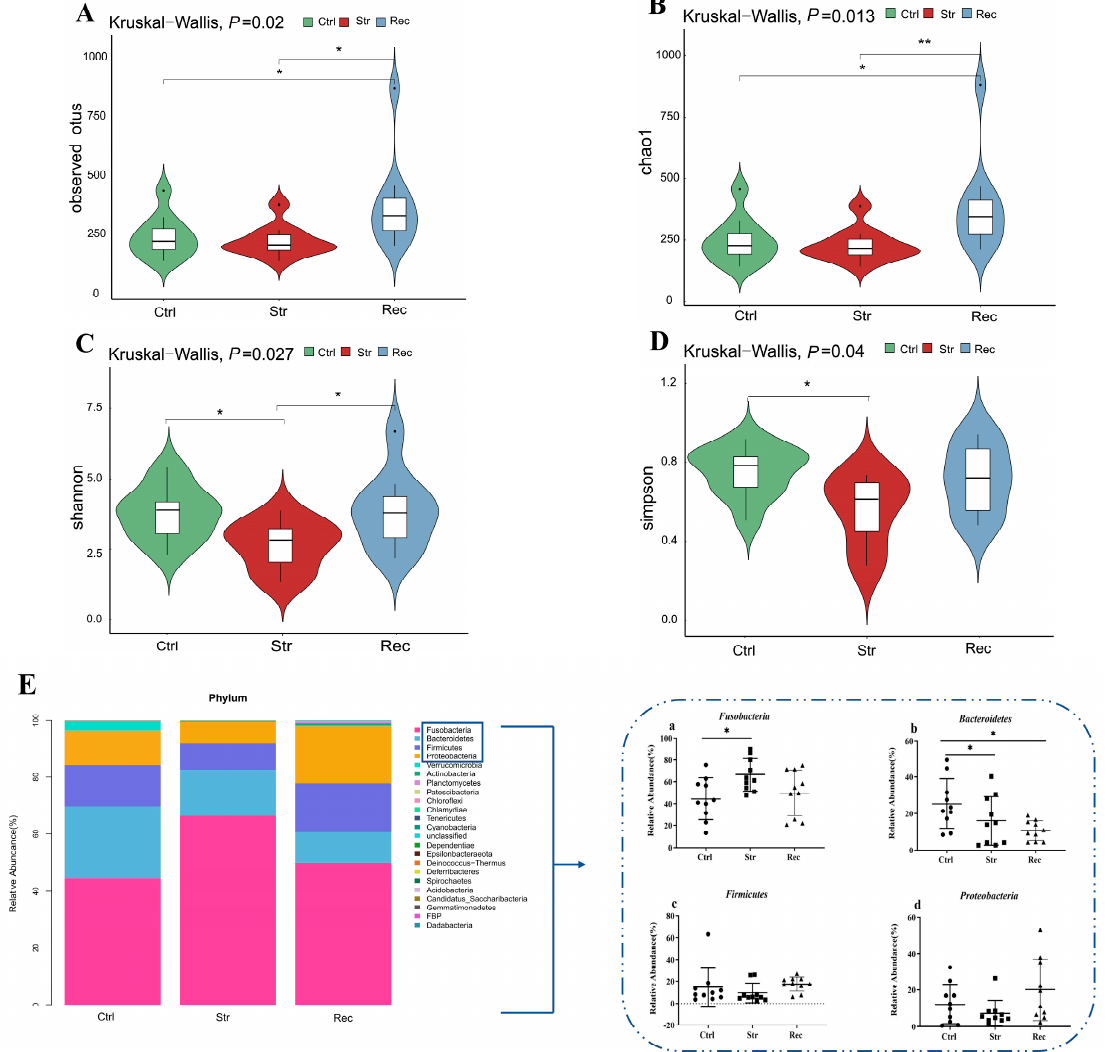
Figure 6. ( A ) Observed species index; ( B ) Chao1 index; ( C ) Shannon’s index; ( D ) Simpson’s index; ( E ) relative abundance of predominant taxa identified at phylum level in control group (Ctrl), transport 16 h group (Str), and recovery group (Rec). Each bar represents relative abundance in each group and 20 most abundant taxa are shown. Relative abundance of four dominate bacterial phyla in three groups showed in ( a – d ). Each shape represents relative abundance in each sample. * ( p < 0.05) and ** ( p < 0.01) indicate significant difference in abundance.